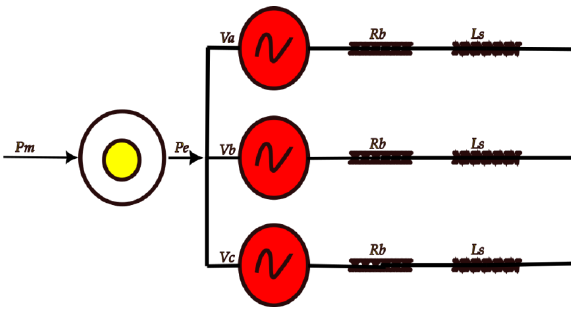
Figure 1. Synchronous Machine model.